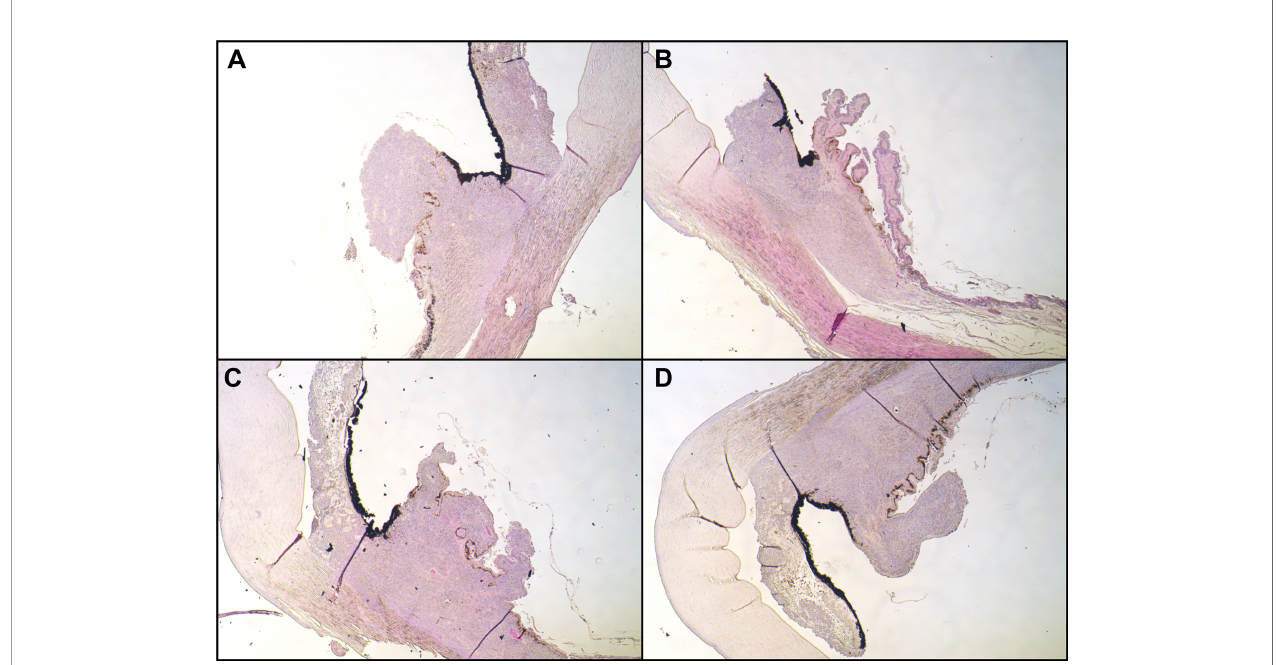
FIGURE 3 | Histopathological examination. Hematoxylin and eosin stain of the iridociliary junction, magni fi cation: ×10. (A) Superior, (B) nasal parts of the iris were missing due to paraf fi n embedding; (C) inferior; (D) temporal. All images expose in fi ltration of an epithelioid-cell-type tumor in fi ltrating the ciliary